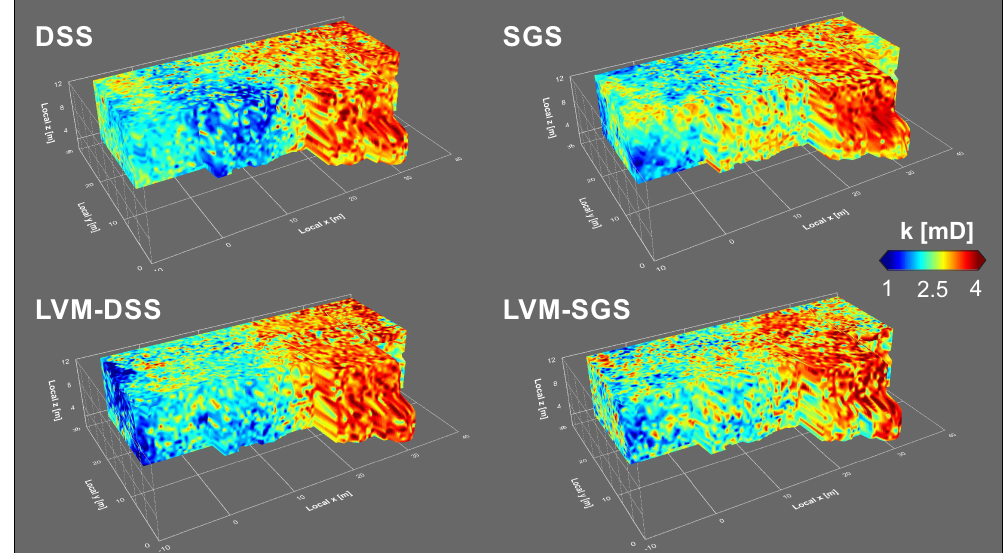
Figure 12. Exemplary model visualizations for the DSS, SGS, LVM-DSS and LVM-SGS